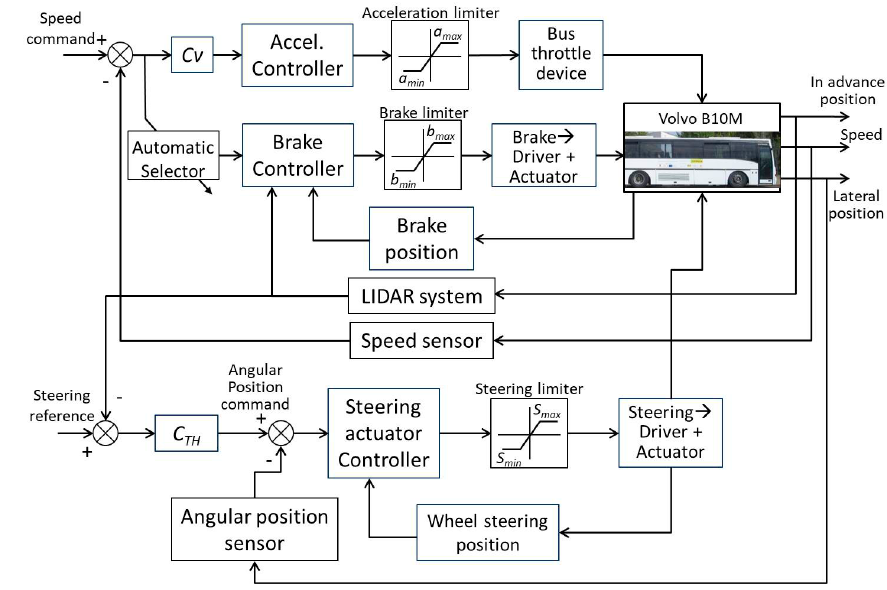
Figure 13. Longitudinal and lateral control scheme.